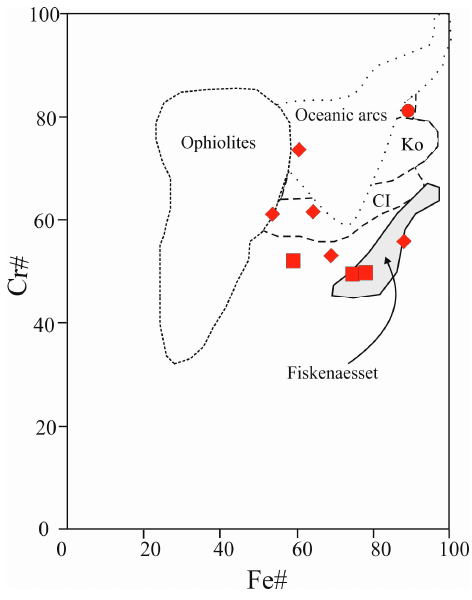
Figure 5. Cr# vs. Fe# diagram. Symbols are as in Figure 2. Fields of oceanic arcs, continental intrusions (CI), komatiites (Ko) and ophiolites are based on Barnes and Roeder (2001) [4], Fiskenæsset field is based on Rollinson et al. (2010) [40].